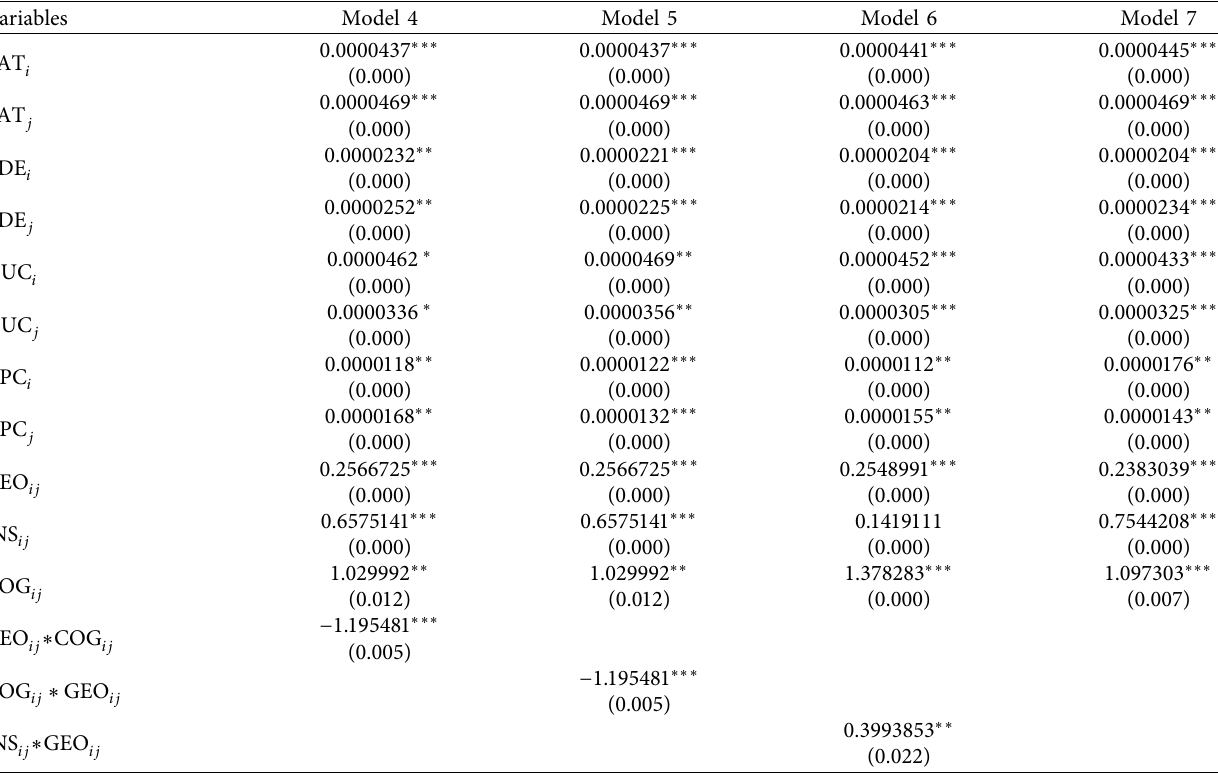
Table 5: Regression results of the interactive model for different